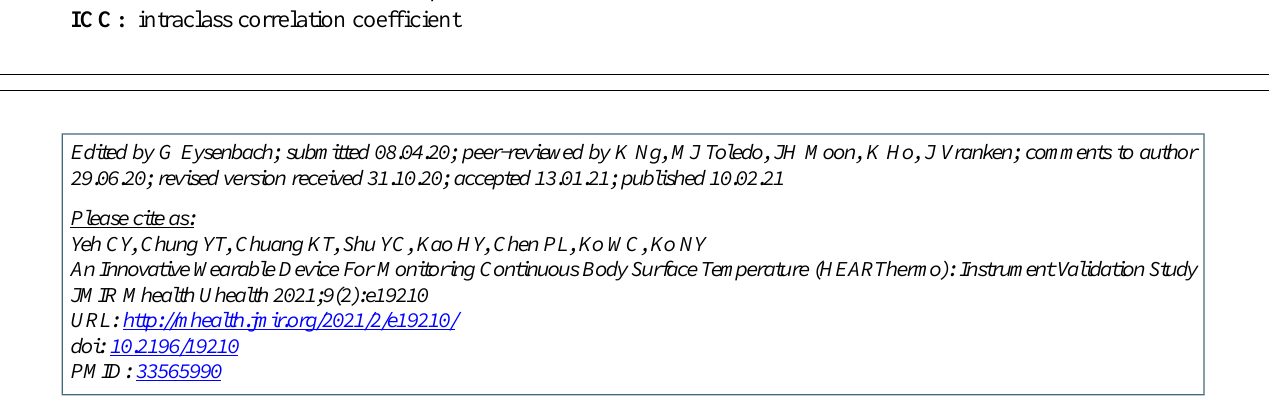
CNS: National Standards of the Republic of China ICC: intraclass correlation